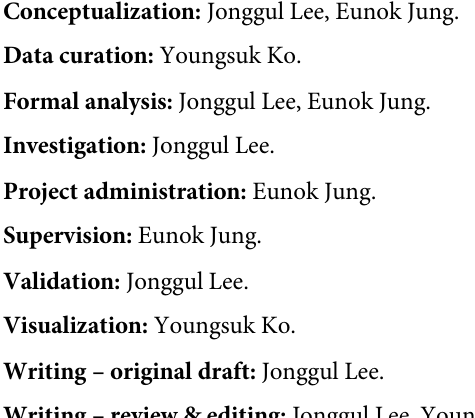
S2 Table. Time series outbreak data (duck farms) of the sixteen towns [1]. S3 Table. Pairwise distance matrix of the sixteen towns ( km ). S4 Table. Daily AI report and IP culling number. This are gathered and translated from HPAI infection daily reports of the Ministry of Agriculture, Food and Rural Affairs